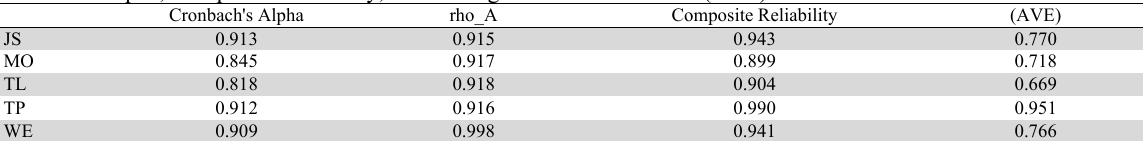
Cronbach's Alpha, Composite Reliability, and Average Variance Extracted (AVE)